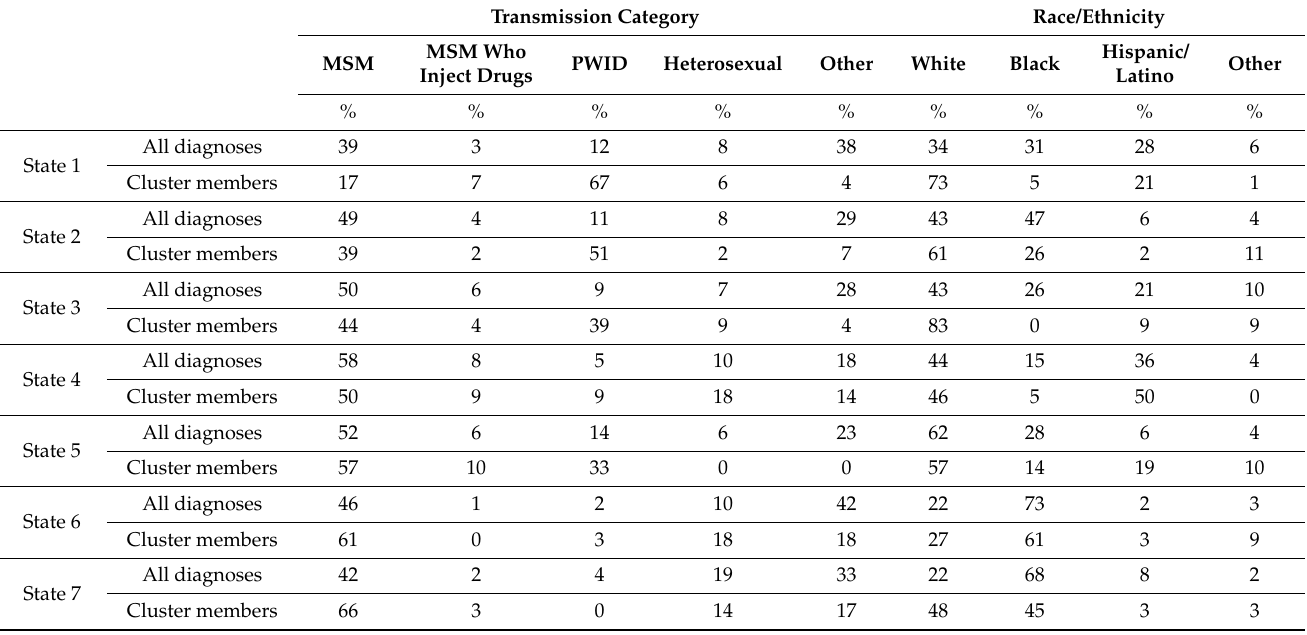
Table 1. Transmission category and race/ethnicity of people with HIV diagnosed in 2018–2019 and people in molecular HIV clusters first detected in 2018–2019, by state. MSM: men who have sex with men; PWID: people who inject drugs. Only includes states with at least 20 cluster members.